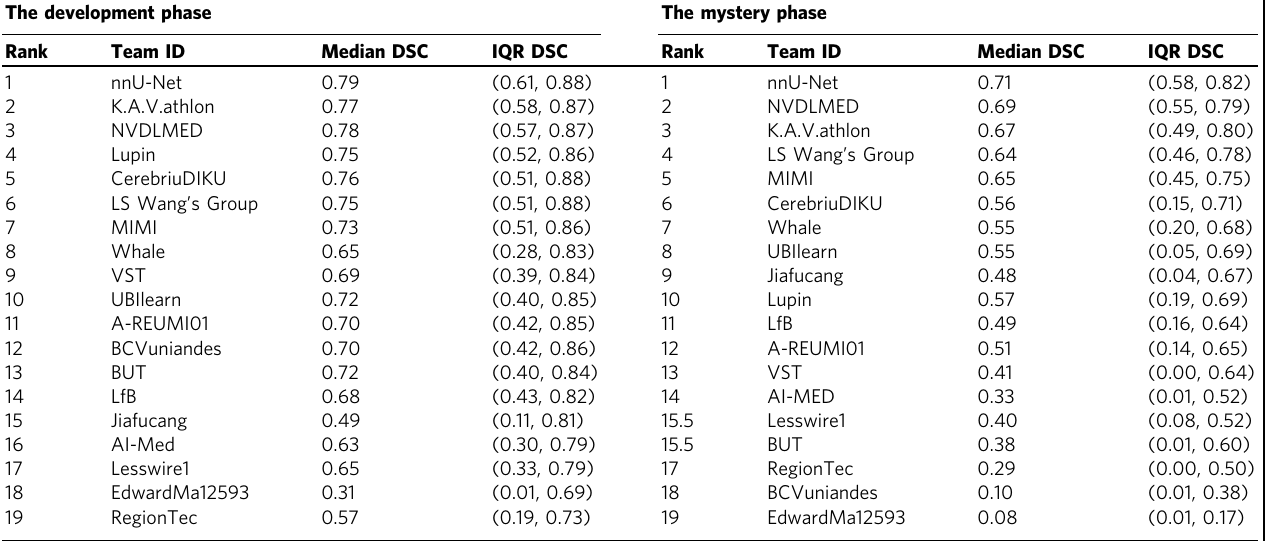
Table 1 Rankings for the development phase and the mystery phase, median and interquartile range (IQR) of the Dice Similarity Coef fi cient (DSC) values of all 19 teams.